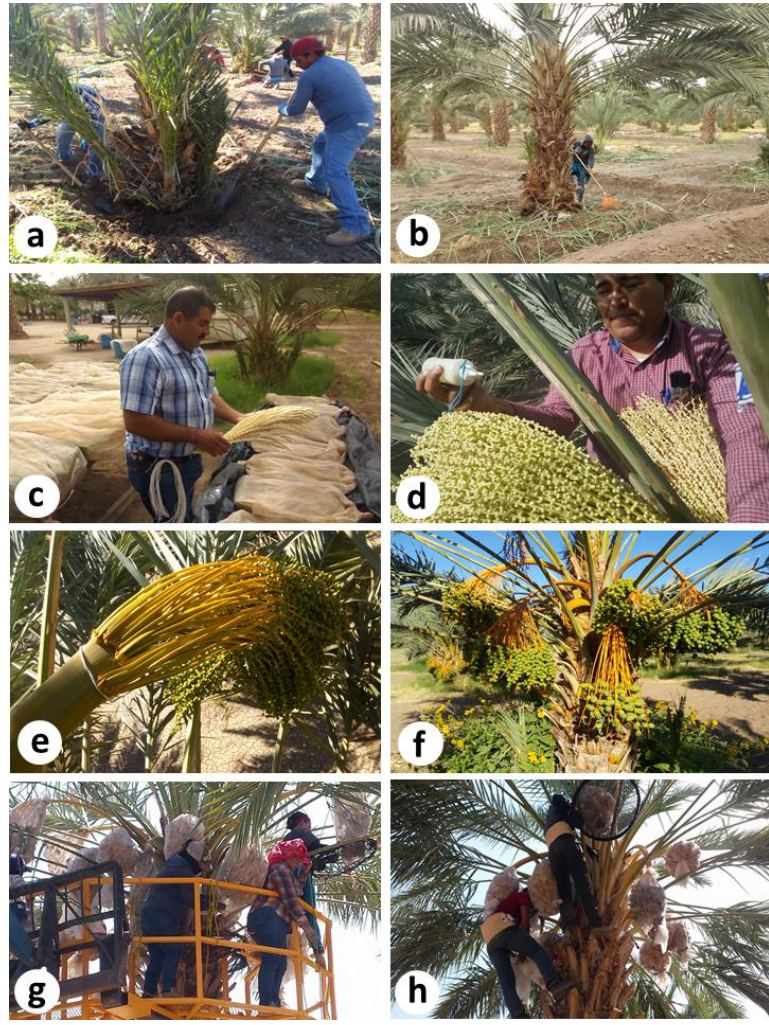
Figure 4. Cultural practices. ( a ) Removal of palm offshoots. ( b ) Elimination of thorns and leaves in the palm. ( c ) Drying male spathes for pollen extraction. ( d ) Pollination process. ( e ) Spathe 2 months after pollination. ( f ) Young palm with fruit of various sizes. ( g ) Women working on the harvest of the date on board a mechanical basket. ( h ) Traditional method of harvesting dates.